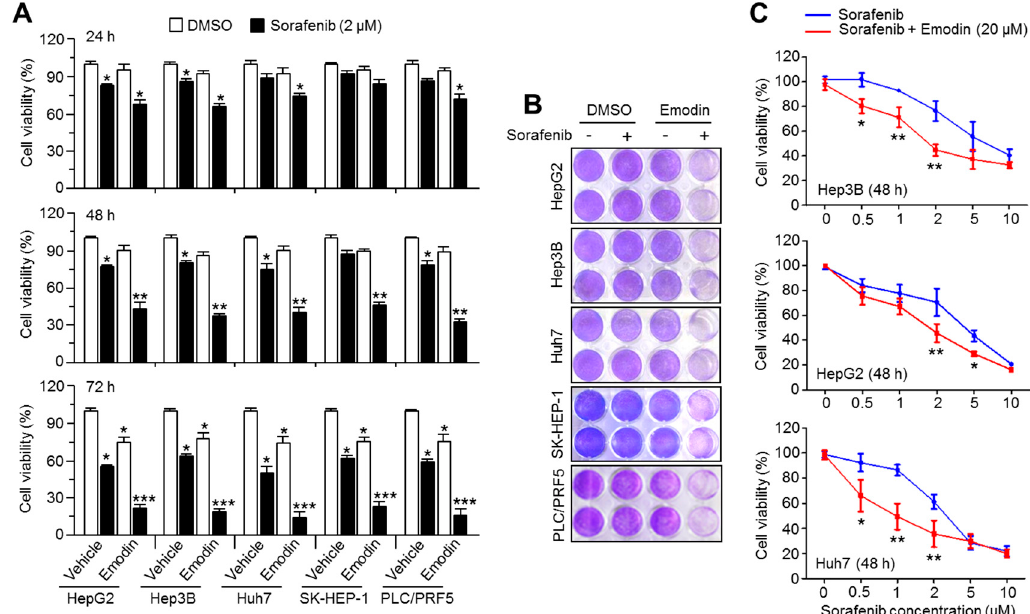
( A ) Cell viability analysis after emodin, sorafenib, or the combination treatment of both drugs in five HCC cell lines. The cells were incubated with emodin (20 µ M), sorafenib (2 µ M), or the combination (20 µ M emodin and 2 µ M sorafenib) for 24, 48, or 72 h, as indicated. The values represent the mean ± SEM of three independent experiments performed in triplicate; * p < 0.05, ** p < 0.01, and *** p < 0.001. ( B ) Images of crystal violet staining. ( C ) The cell viability after different concentrations of sorafenib (0.5, 1, 2, 5, and 10 µ M) with 20 µ M emodin in Hep3B, HepG2, and Huh7 cells. The values represent the mean ± SEM of three independent experiments performed in triplicate; * p < 0.05 and ** p <